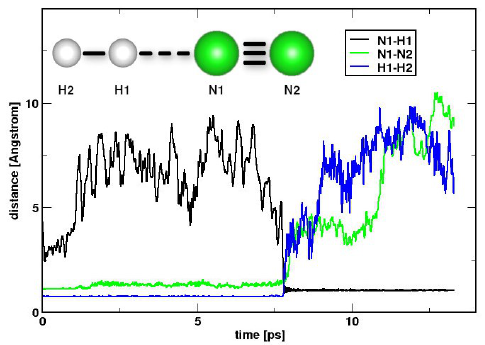
Figure 6. Simulation 23 , first reaction: a hydrogen atom is readily transferred from an OH group to nitrogen, causing N-N bond breaking.